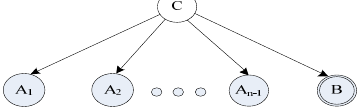
Fig. 1. The structure of LGNB